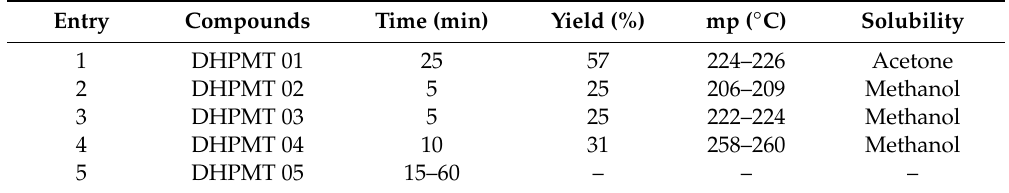
Table 1. Results of the synthesis of DHPMTs